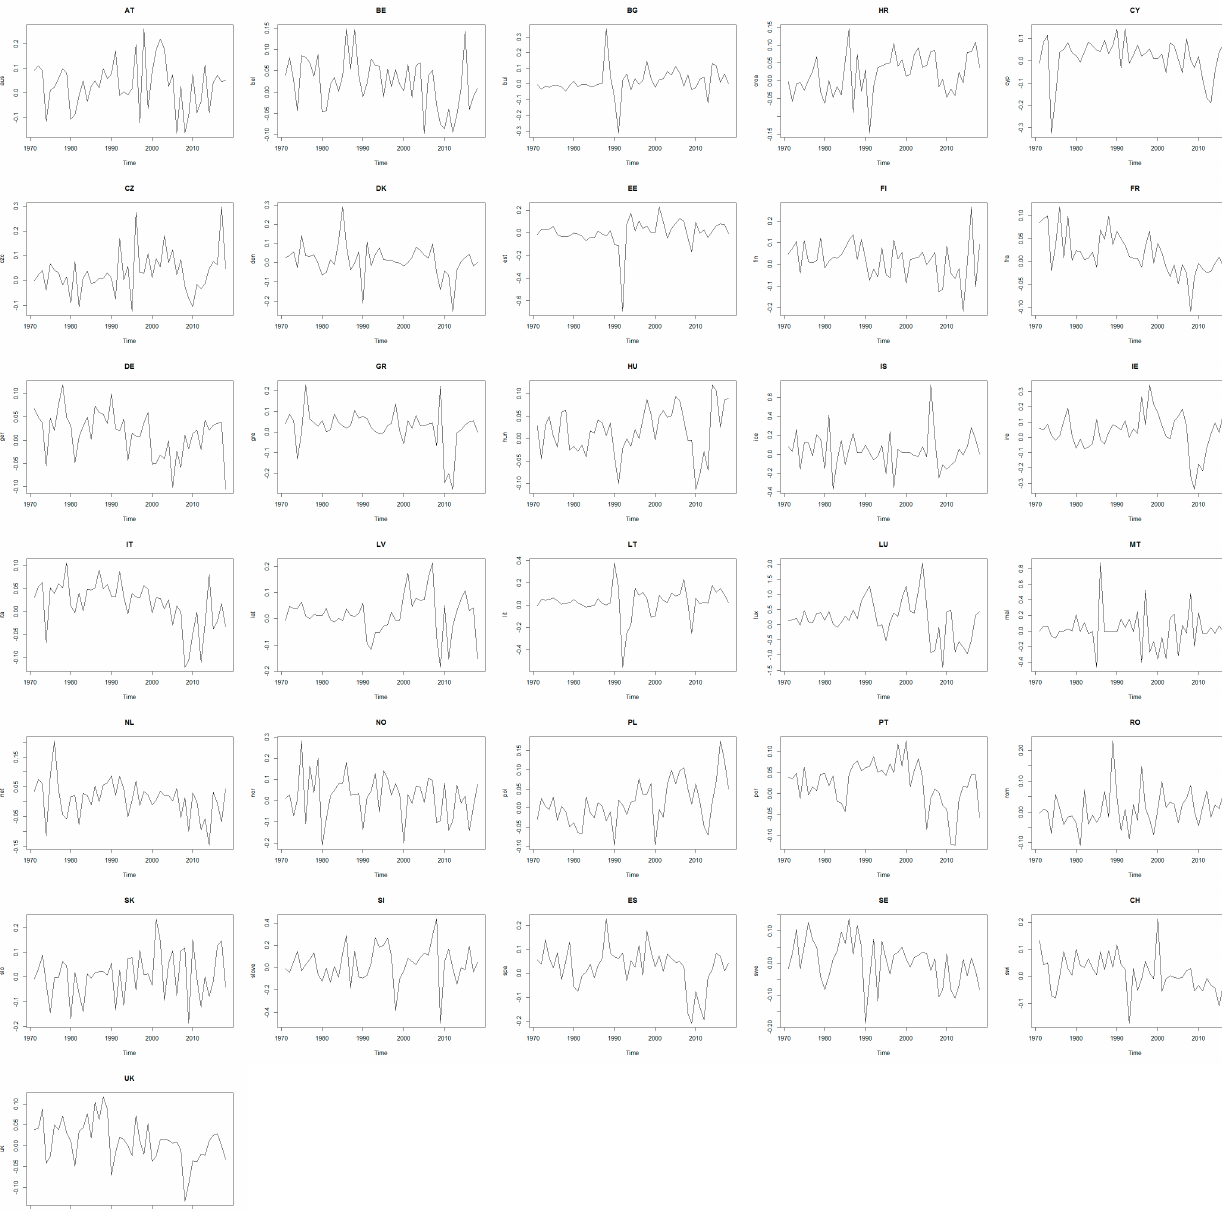
2 emission changes from 1970 to